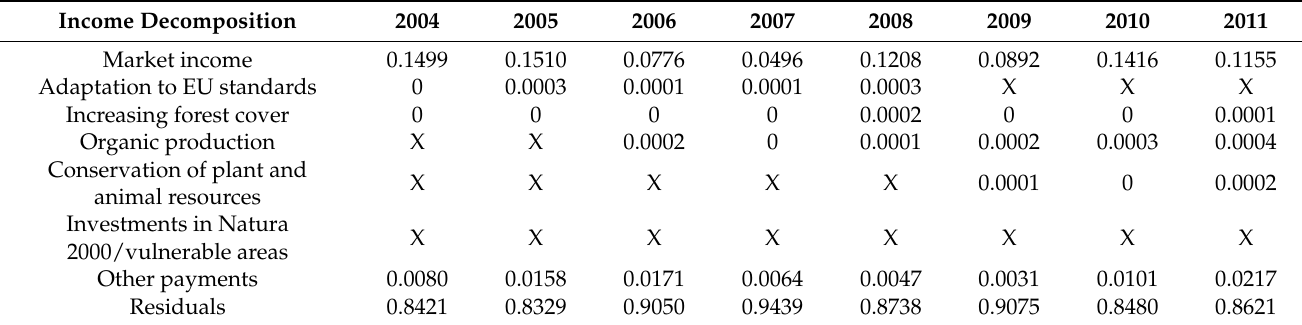
Table 6. Decomposition of income inequalities for individual instruments under “green” CAP